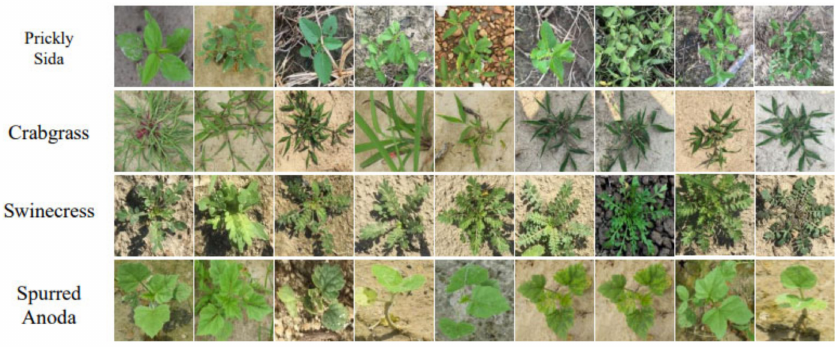
Figure 1. Examples of weed images used for transfer learning.